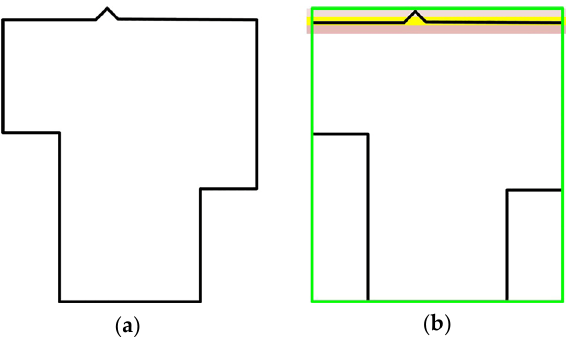
Figure 4. The workflow of the cuboid abstraction processing.